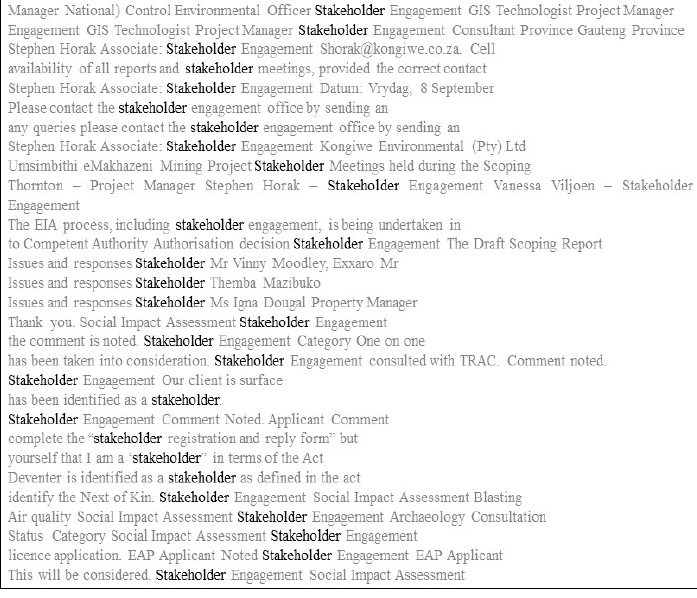
Figure A4. Collocation analysis, Public Participation Figure A4: Collocation analysis, Public Participation Report. Figure A4: Collocation analysis, Public Participation Report.